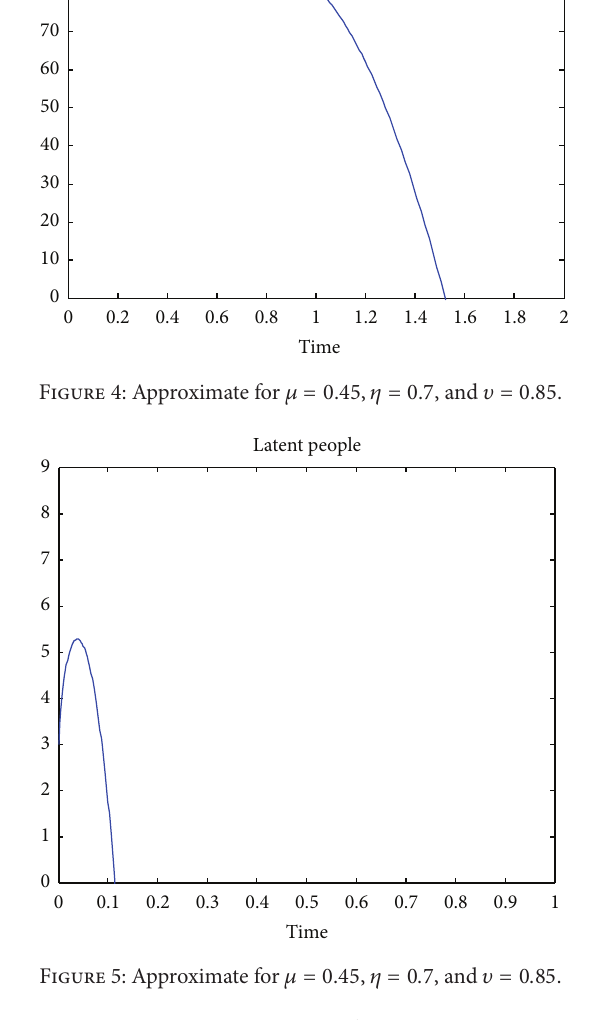
Figure 8: Approximate for 𝜇 = 0.045 , 𝜂 = 0.5 , and 𝜐 = 0.085